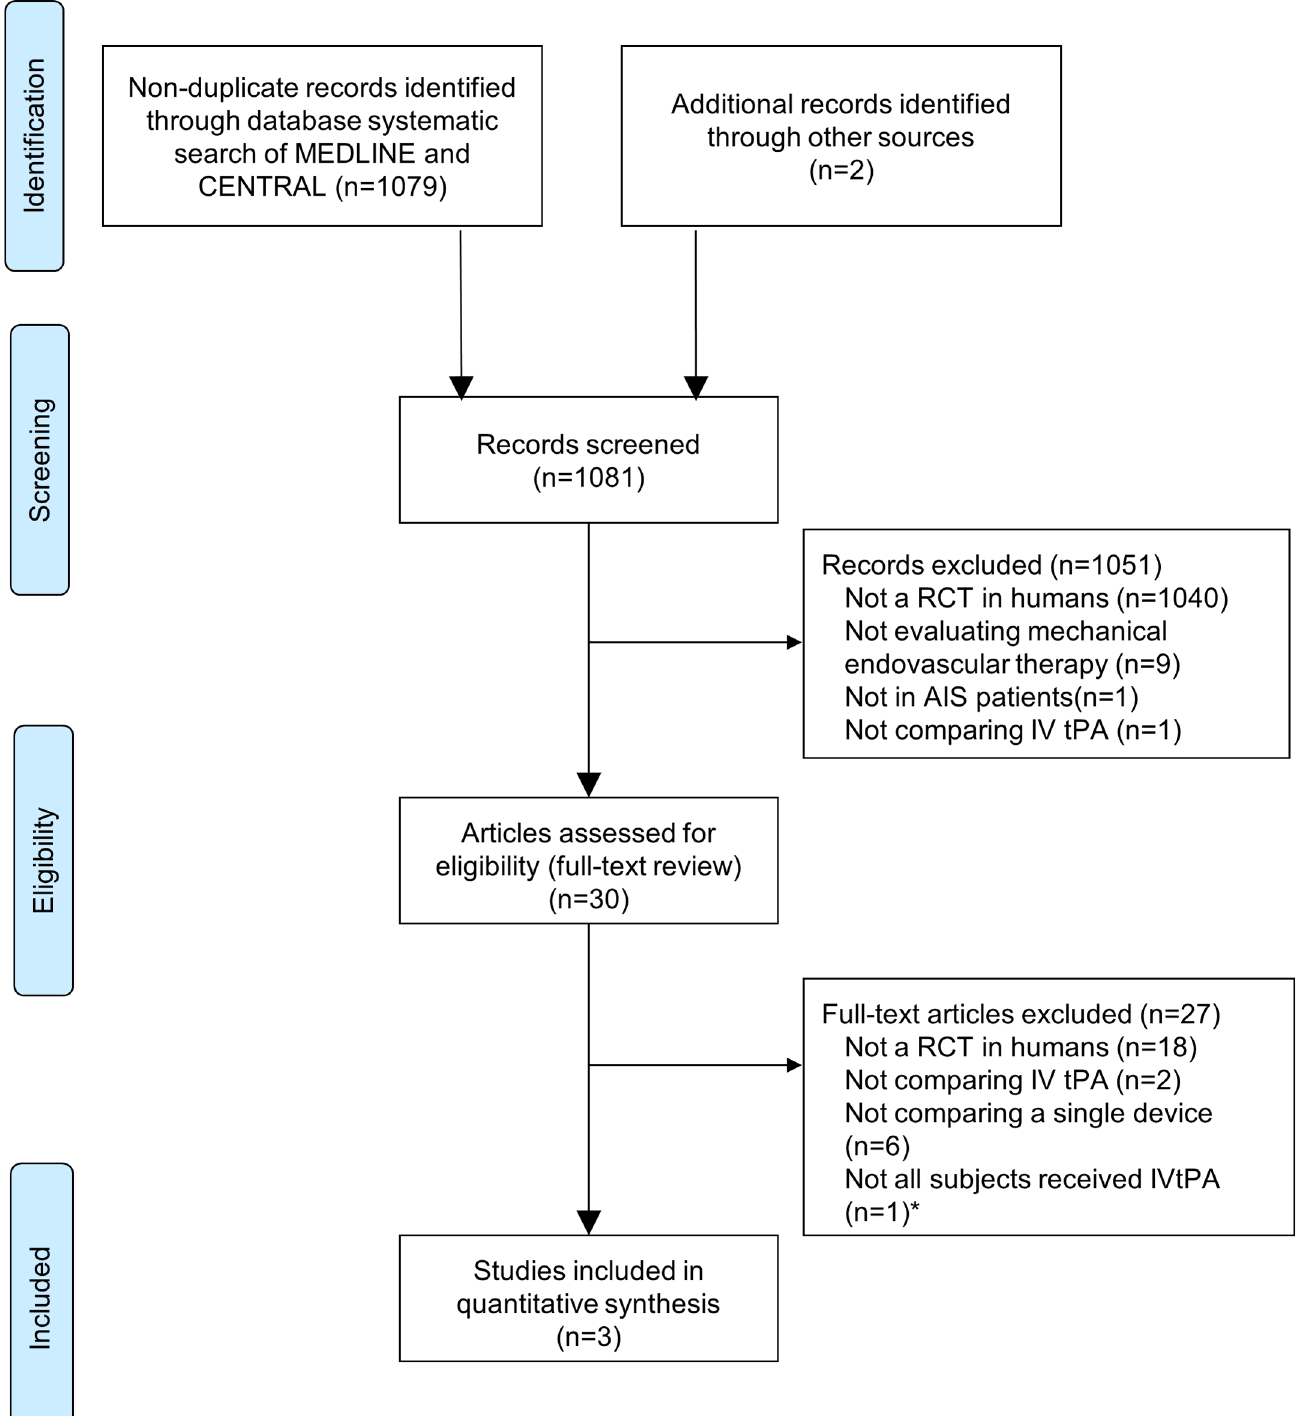
Fig 1. Flow diagram of study selection process for the systematic review and indirect treatment comparison. (cid:3) REVASCAT met all other inclusion criteria, therefore it was included in the sensitivity analysis.